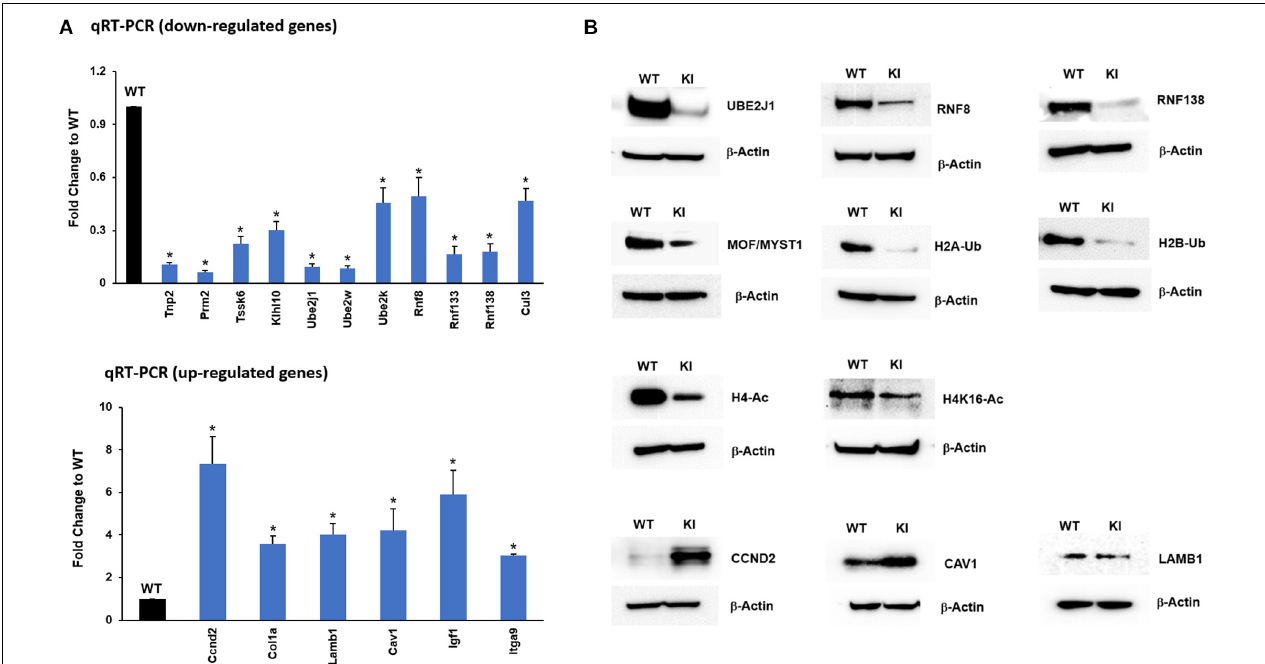
FIGURE 4 | RNA-Seq data validation by qRT-PCR and Western blot. (A) Expression of selected up-regulated and down-regulated genes from the RNA-seq data was measured by qRT-PCR relative to actin in KI vs WT mice. Histograms represent the fold change expression between KI and WT group. Means ± SEM were determined from three sets of qRT-PCR experiments with each sample run in triplicates. P -values were calculated by two-tailed Students t -test (asterisks indicates P < 0.05). (B) Western blots showing the protein expression of UBE2J1, RNF8, RNF138, MOF/MYST1, H2A/B-Ub (Ubiquitinated Histone 2A/B), H4-Ac (Acetylated Histone 4), H4K16-Ac, CCND2, CAV1, and LAMB1 in KI and WT mice.